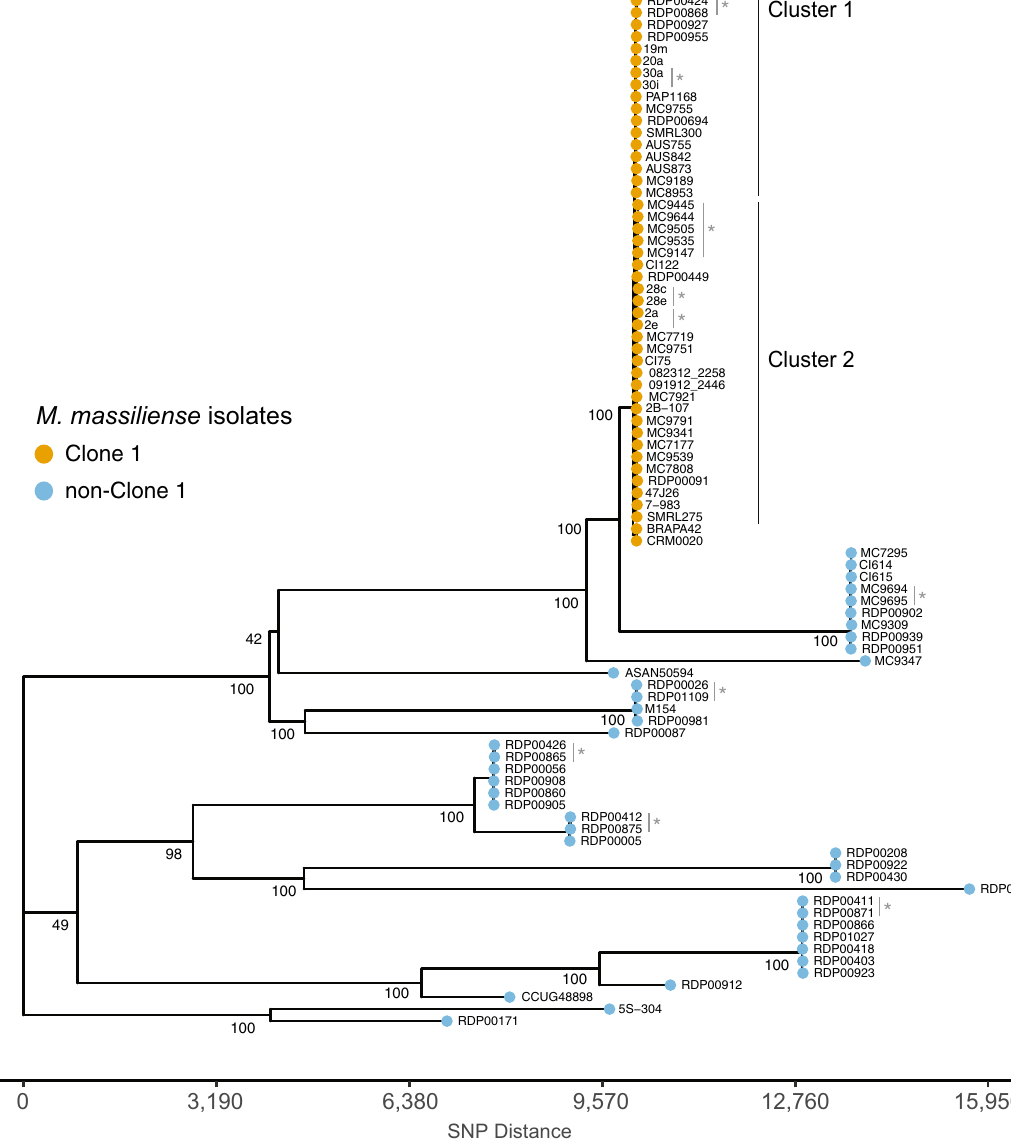
Figure 1. Phylogenomic analysis of M. massiliense isolates in the study (n = 100). Genome-wide SNP data at 63,841 positions was analyzed using the neighbor-joining algorithm. Bootstrap support values for the basal nodes are shown. The M. massiliense type strain CCUG48898 T is included among non-Clone 1 isolates. Longitudinal isolates are shown with grey bars and asterisks. Clusters within the Clone 1 clade are labeled on the